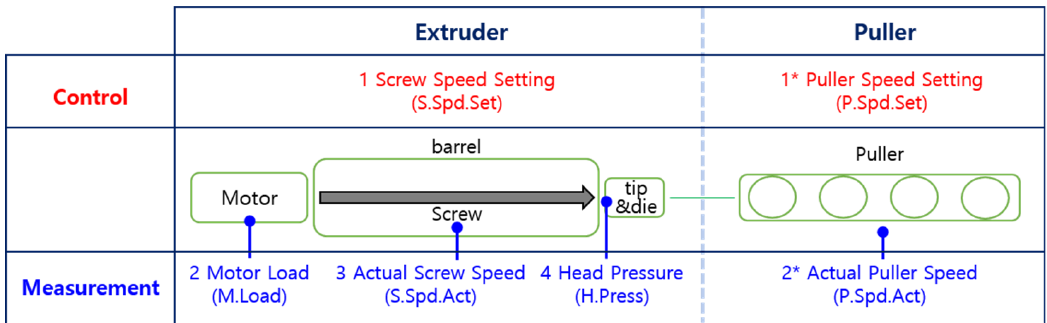
Figure 3. Screw wear ‐ related parts and sensing location.